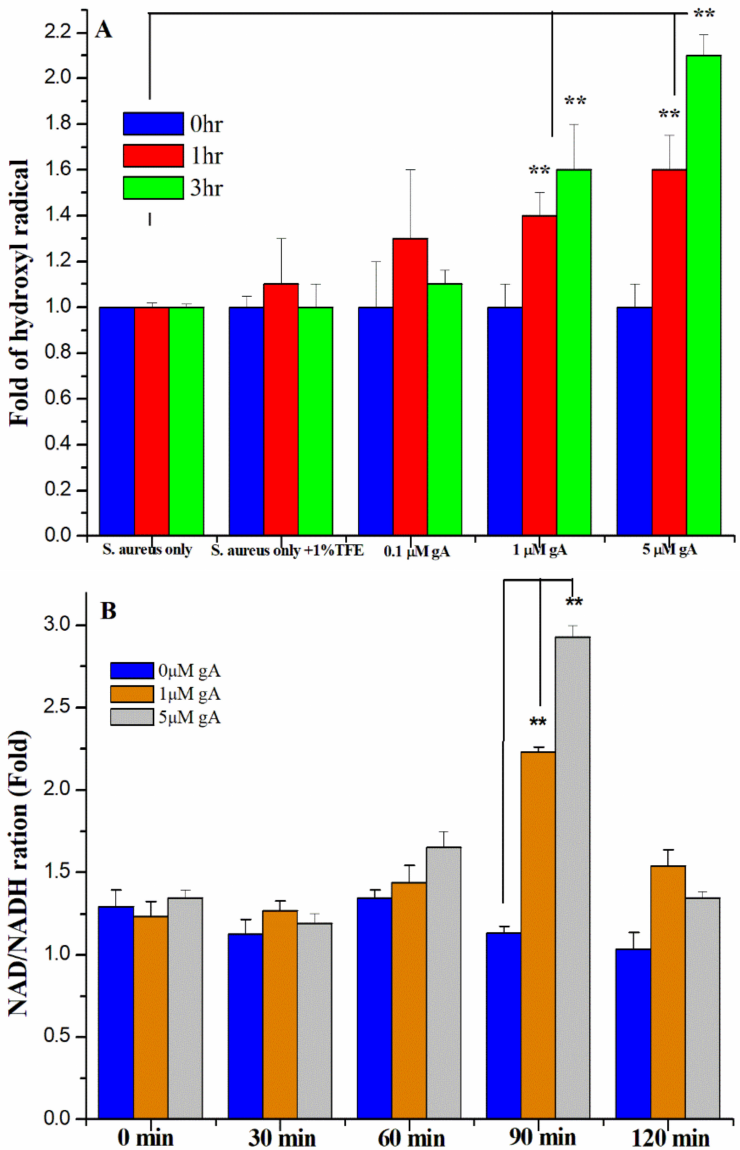
Figure 2. ( A ) Hydroxyl free radical level for S. aureus under the treatment of 0, 0.1, 1, and 5 µ M of gramicidin A, and ( B ) the NAD + /NADH ratio measured for S. aureus under the treatment of 0, 1, and 5 µ M of gramicidin A and 0, 30, 60, 90, and 120 min at the elongation state. ( n = 9, ** p <